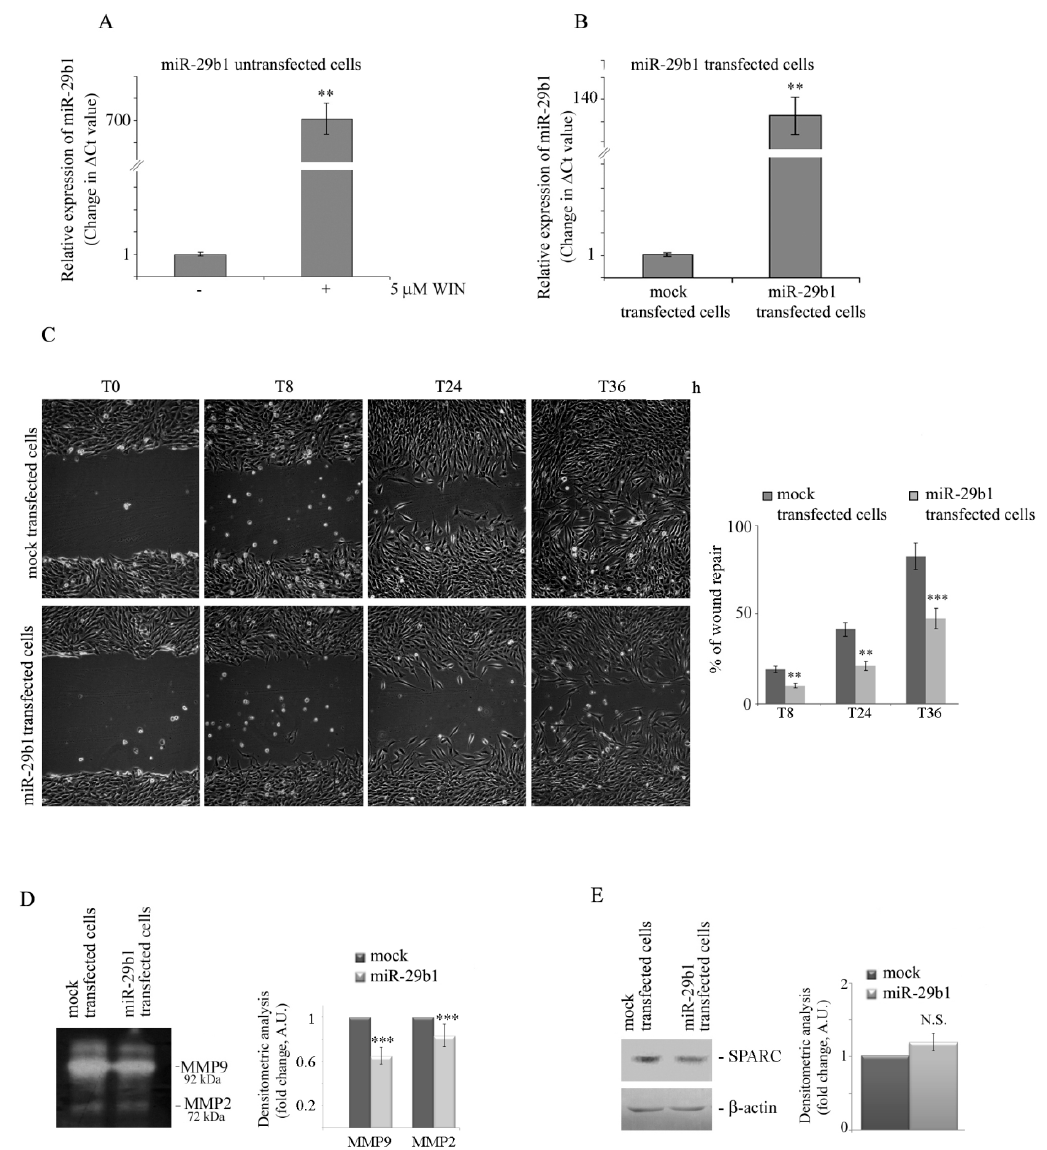
Figure 7. WIN induces a dramatic increase in miR-29b1 expression, and miR-29b1 overexpression reduces cell migration. ( A ) Gene expression levels of miR-29b1 in untreated or 5 µ M WIN-treated cells for 24 h were analysed by RT-qPCR. (**) p < 0.01 compared to untreated cells. ( B ) Validation of gene expression changes in cells stably transfected with miR-29b1 versus mock transfected cells. The height of each column reflects the ratio of the expression of miR-29b1 compared to U6 (a non-coding small RNA used as a control) (**) p < 0.01 and (***) p < 0.001 compared to the untreated cells at the same time point. ( C ) Wound healing migration assay of miR-29b1-transfected MG63 cells in comparison with